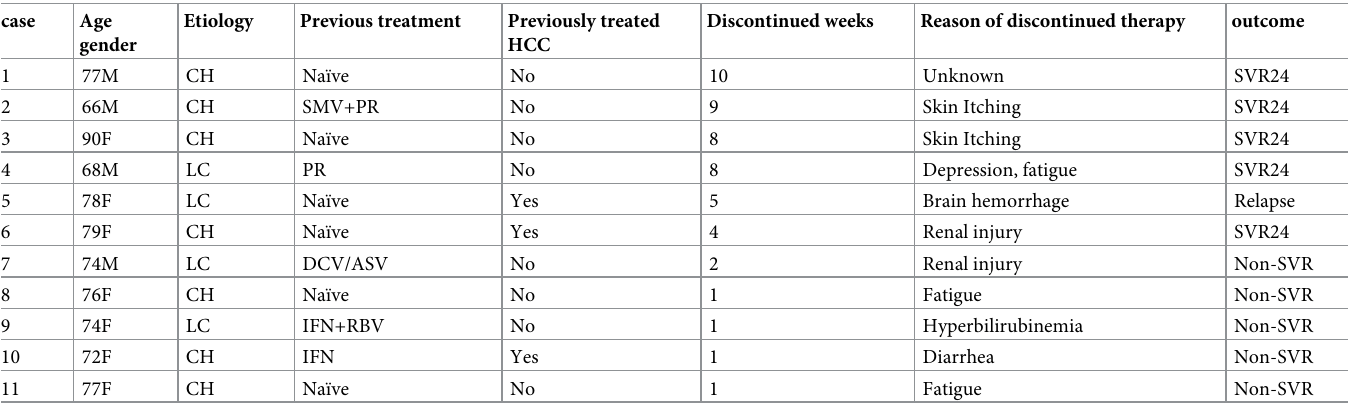
Table 5. The reasons for the discontinuation of